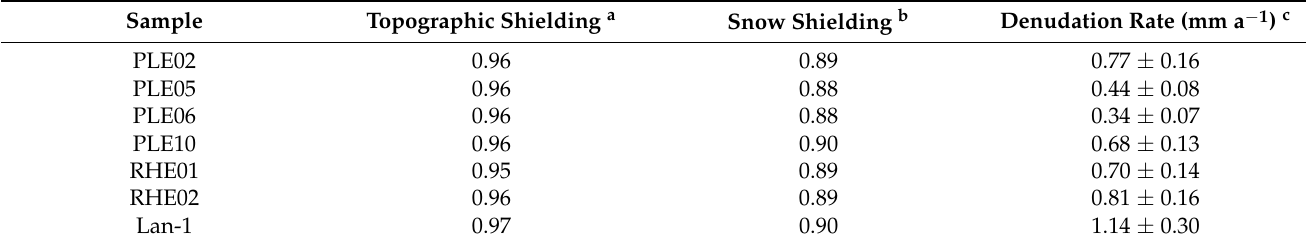
Table 6. 10 Be derived denudation rates.